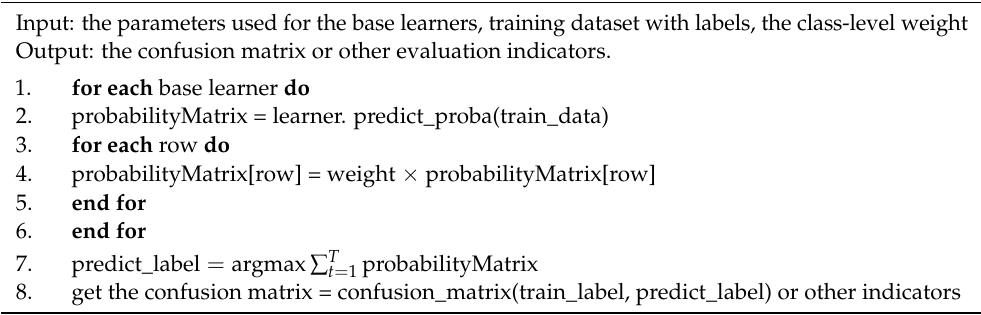
Algorithm 1: The Class-Level Soft-Voting Ensemble